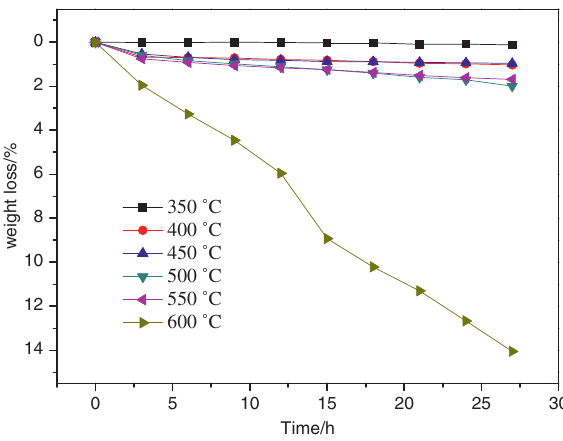
Figure 4: Weight loss vs time of purified potassium nitrate molten salt at different temperatures.